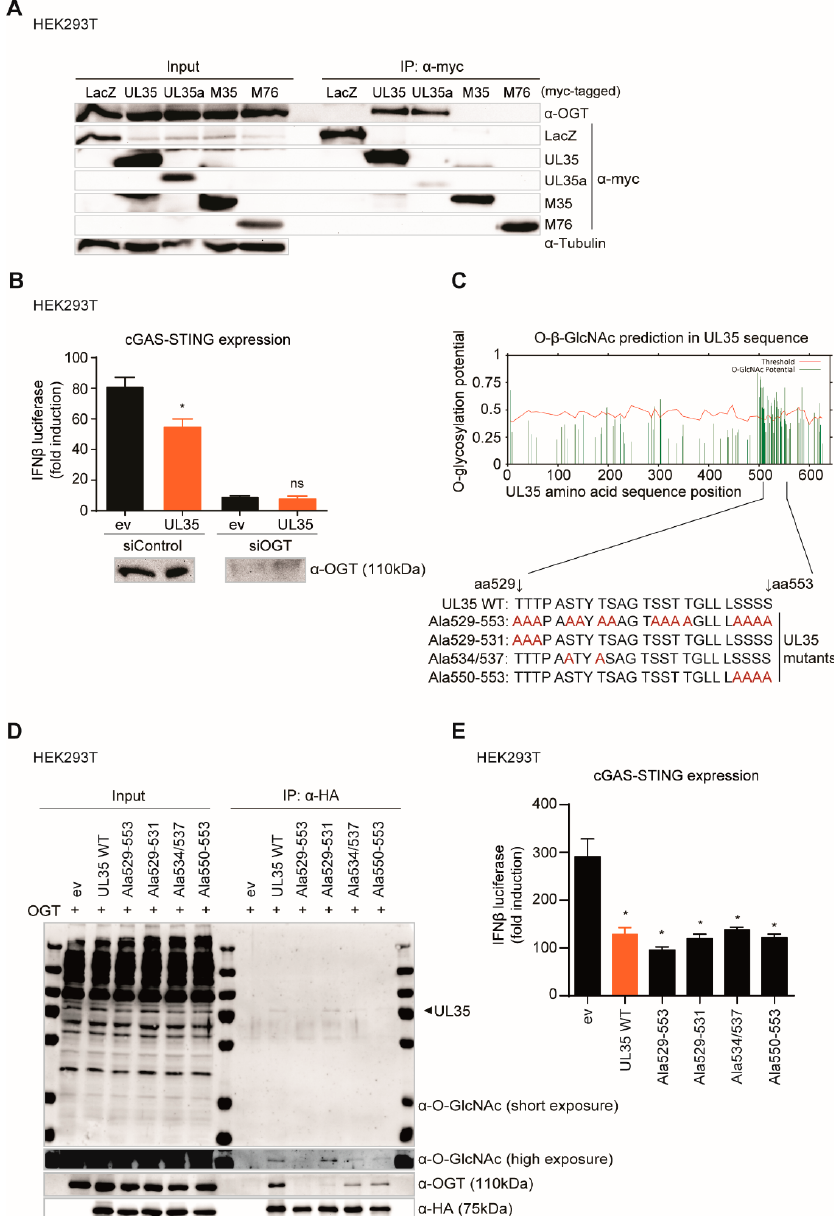
Figure 6. GlcNAcylation and OGT interaction of UL35 is not needed for its antagonistic function. ( A ) HEK293T cells were transfected with myc-tagged LacZ, UL35, UL35a, M35, or M76 and cell lysates were subjected to immunoprecipitation (IP) with an anti-myc antibody. Input and IP samples were analyzed by immunoblotting with antibodies specific for OGT, myc, and tubulin. ( B ) HEK293T cells were reverse transfected with either control siRNA or siRNA specific for OGT. 48 h later, cells were co-transfected with cGAS (stimulated) or IRES-GFP (unstimulated), Cherry-STING, IFN β -Luc, pRL-TK, and either ev or HA-tagged UL35. Lysates for measuring luciferase activity were collected 20 h later and analyzed as described before. ( C ) Potential O-GlcNAcylation sites were predicted within the UL35 amino acid sequence (Ref. seq. YP_081494.1) using the YinOYang 1.2 online server tool. High potential serine and threonine residues within UL35 aa positions 529–553 were mutated to alanines (depicted in red). ( D ) HEK293T cells were co-transfected with expression constructs for OGT and either ev or HA-tagged UL35 expression constructs. 20 h later, proteins were immunoprecipitated using an HA-specific antibody and separated by SDS-PAGE. GlcNAcylation was analyzed by